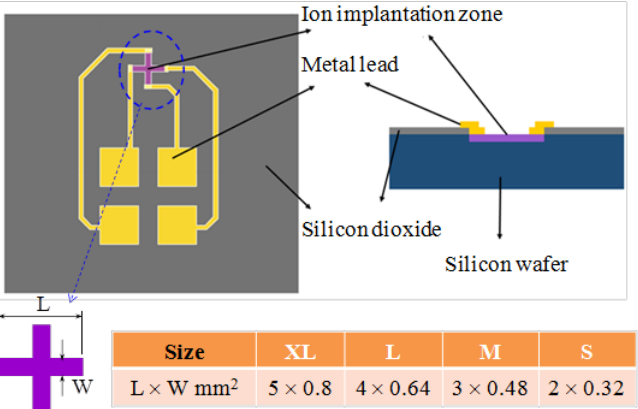
Figure 2. Schematic illustration of Hall sensor design and dimensions of four sizes of cross-shaped detection zones.